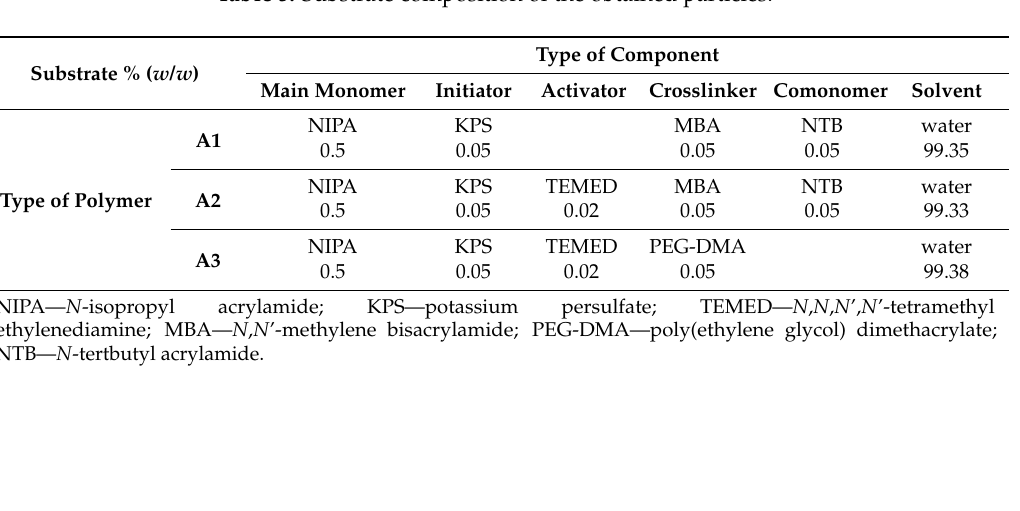
Table 5. Substrate composition of the obtained